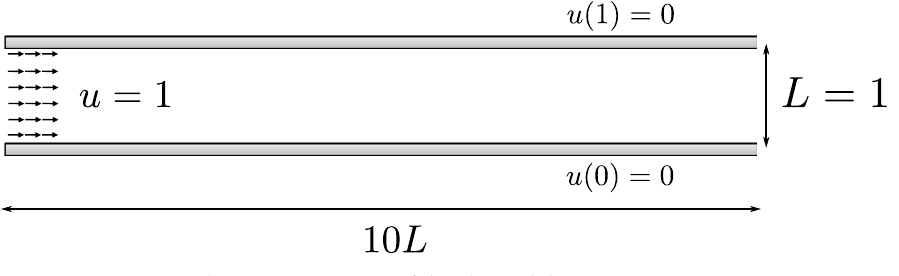
Figure 3. Dimensionless representation of the channel